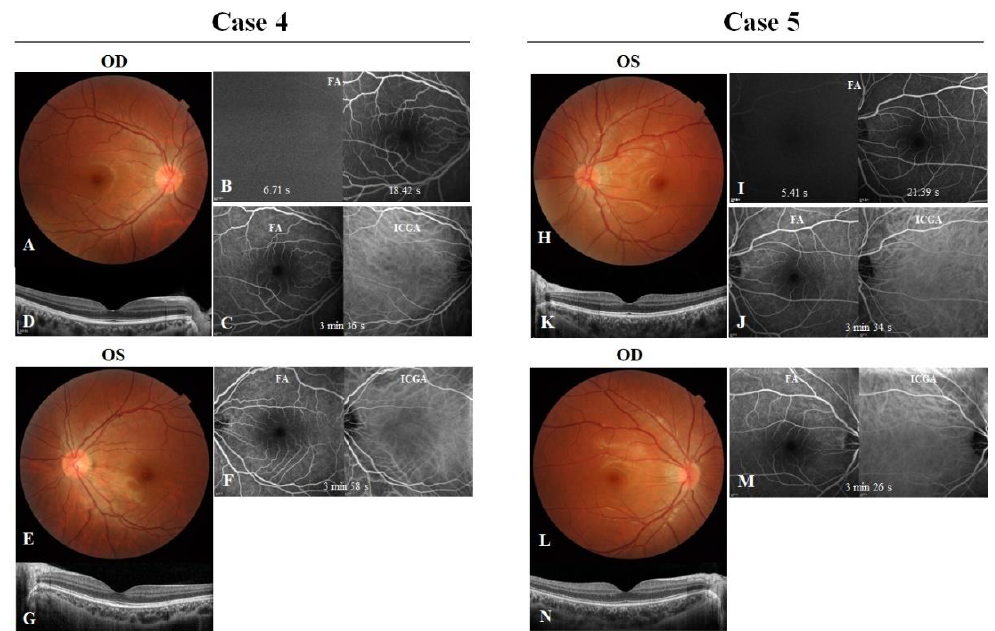
Figure 5. Cases 4 and 5. ( A , E ) In case 4, fundus photographs of the right and left eyes showed slightly tortuous veins. ( B ) Fluorescein angiography (FA) of the right eye showed that the dye appeared in the superiortemporal arteries at 6.71 s, and the major vein in the corresponding area was completely filled at 18.42 s. Optical coherence tomography (OCT) images ( D , G ), FA and indocyanine green angiography (ICGA) ( C , F ) of the right and left eyes showed no abnormalities. ( H , L ) In case 5, fundus photographs of the left and right eyes showed tortuous veins in the left eye. ( I ) FA of the left eye, showing that dye appeared at 5.41 s and venous filling was completed at 21.39 s. OCT images ( K , N ), FA and ICGA ( J , M ) of both eyes were apparently normal.